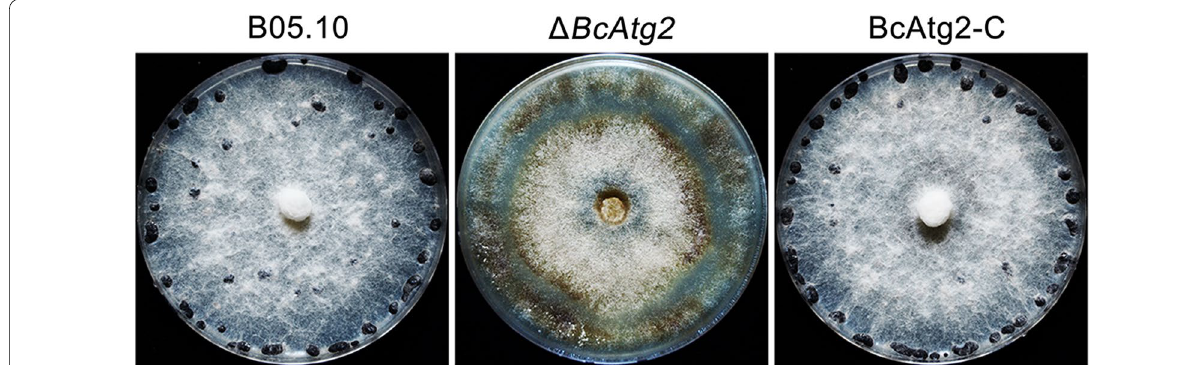
Fig. 6 BcAtg2 is indispensable for sclerotial formation in B. cinerea . The wild-type strain B05.10, BcATG2 deletion mutant Δ BcAtg2 and complemented strain BcAtg2-C were cultured on PDA plates at 10 °C in the dark for 3 weeks